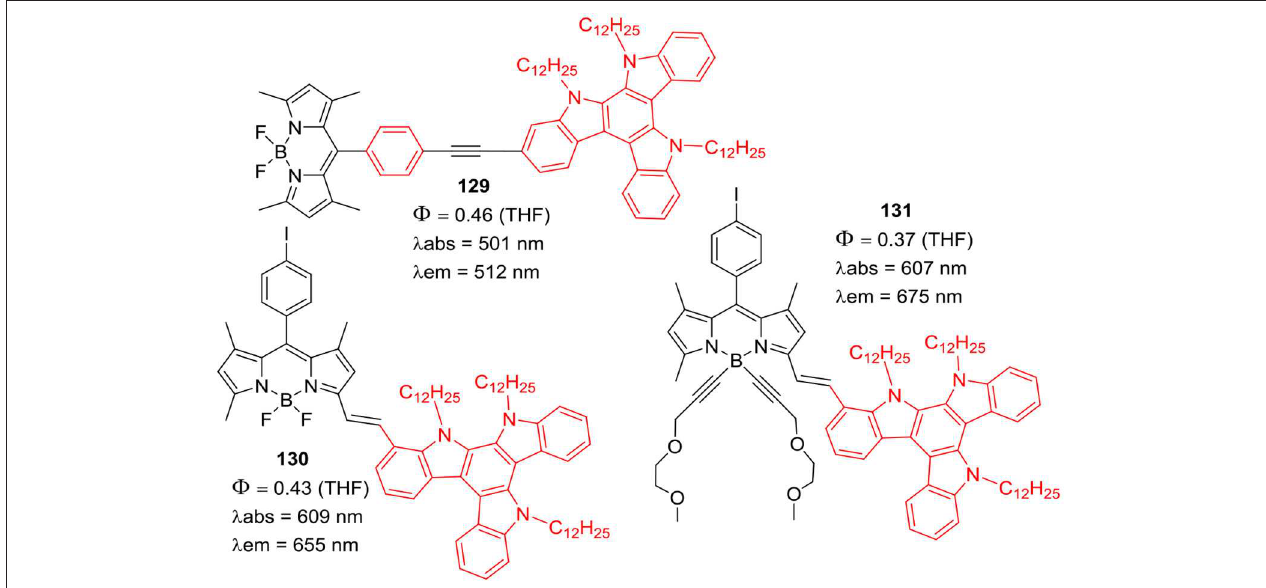
CHART 22 | Triazatruxene linked BODIPY